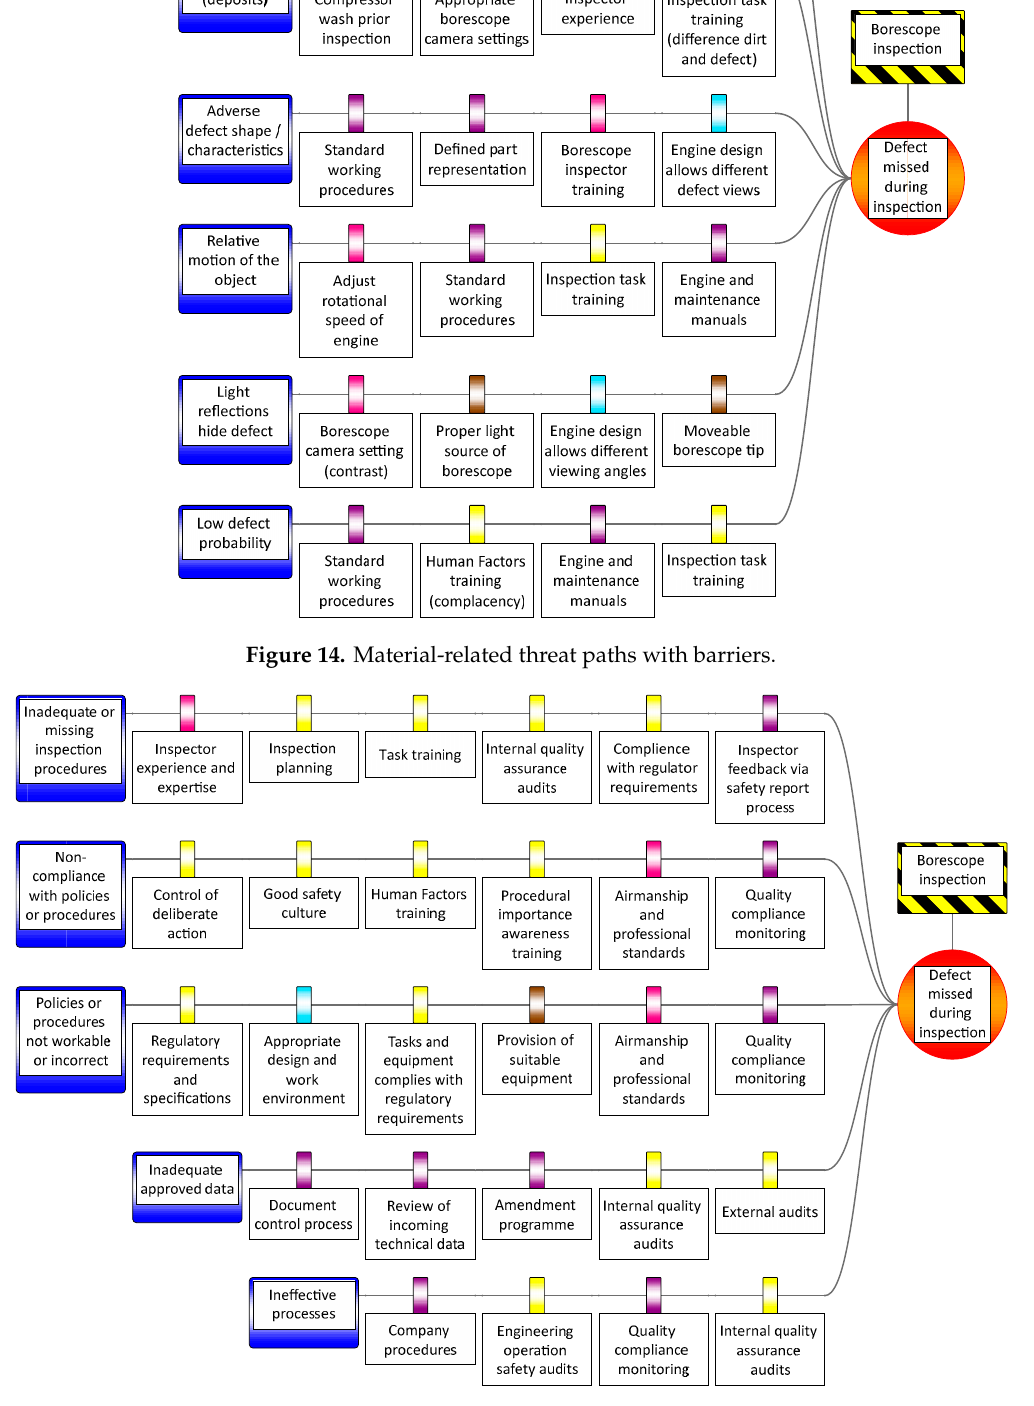
Figure 15. Method-related threat paths with barriers.